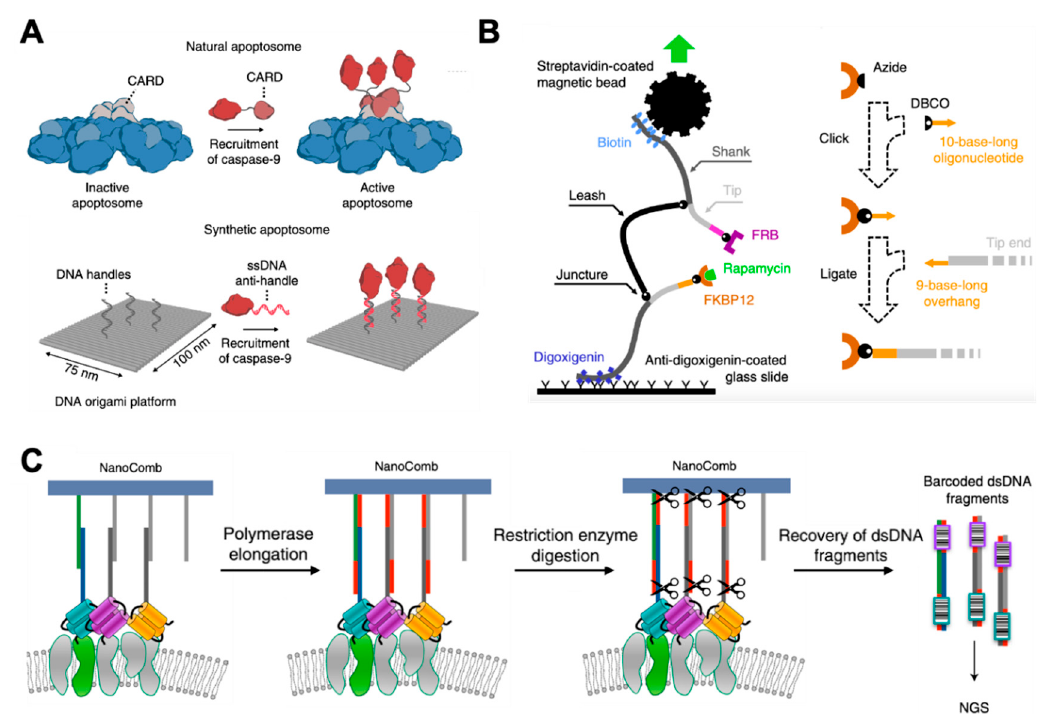
Figure 4. Study of PPIs based on DNA nanotechnology methods. ( A ) Self-assembled 2D peptide nanostructure, adapted with permission from [106]. ( B ) Structure of the junctured-DNA tweezer (left) and the strategy used to attach a given protein at a given tip (right), adapted with permission from [107]. ( C ) Schematic of the DNA NanoComb method, adapted with permission from [10].